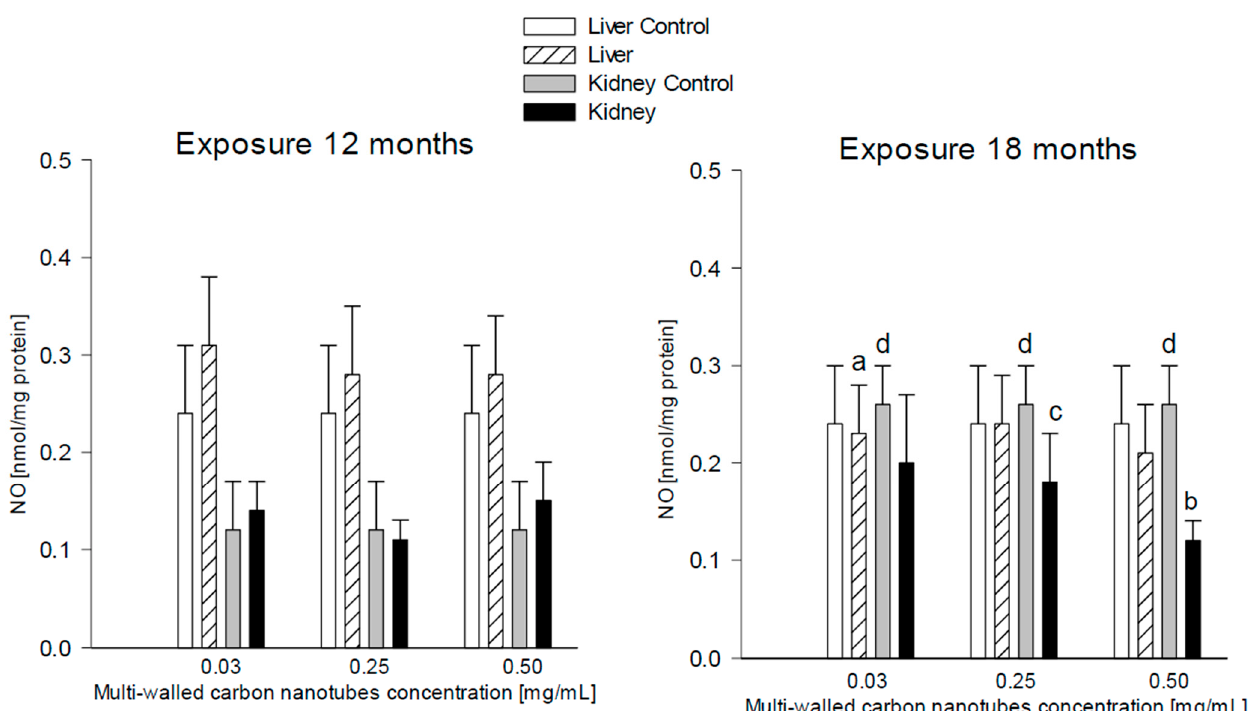
Figure 8. Comparison of nitric oxide (NO) concentrations in the liver and kidneys of animals exposed to multi-walled carbon nanotubes for 12 and 18 months. (a)—statistically significant difference for the group receiving MWCNTs in a concentration of 0.03 mg/mL at 18 months versus 12 months in the livers ( p = 0.051588); (b)—statistically significant difference for MWCNTs in a concentration of 0.5 mg/mL versus control group in the kidneys ( p = 0.0049); (c)—statistically significant difference for the group receiving MWCNTs in a concentration of 0.25 mg/mL at 18 months versus 12 months in the kidneys ( p = 0.008052); (d)—statistically significant difference for the control group at 18 months versus control at 12 months in the kidneys (p = 0.000269 ).